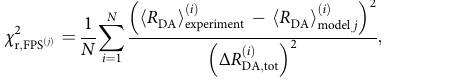
D is caused by the shot noise of the D E